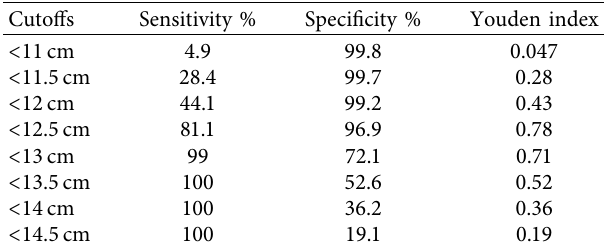
Table 5: Performance of RUAC at different cutoff values in identifying malnourished children against MUAC from Lanfro District, Silte Zone, SNNPR 2016 ( n �